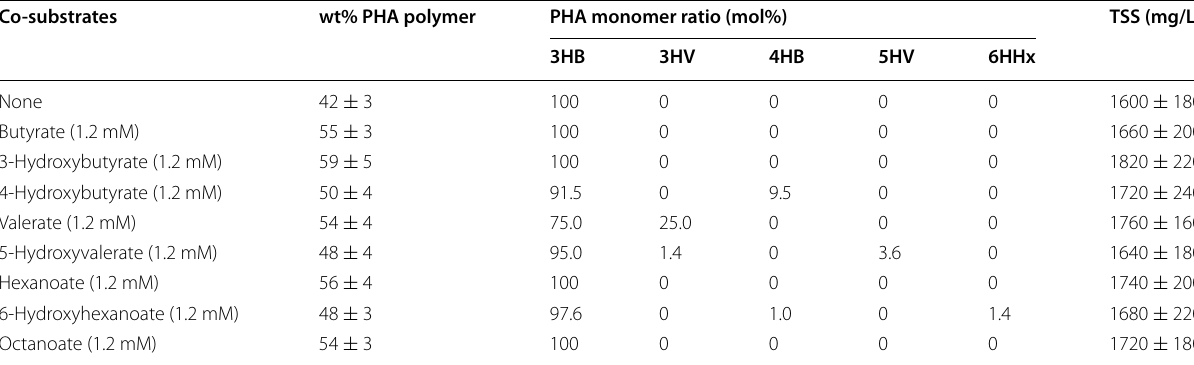
Table 1 PHA production using various fatty acid co-substrates by M. parvus OBBP Co‑substrates